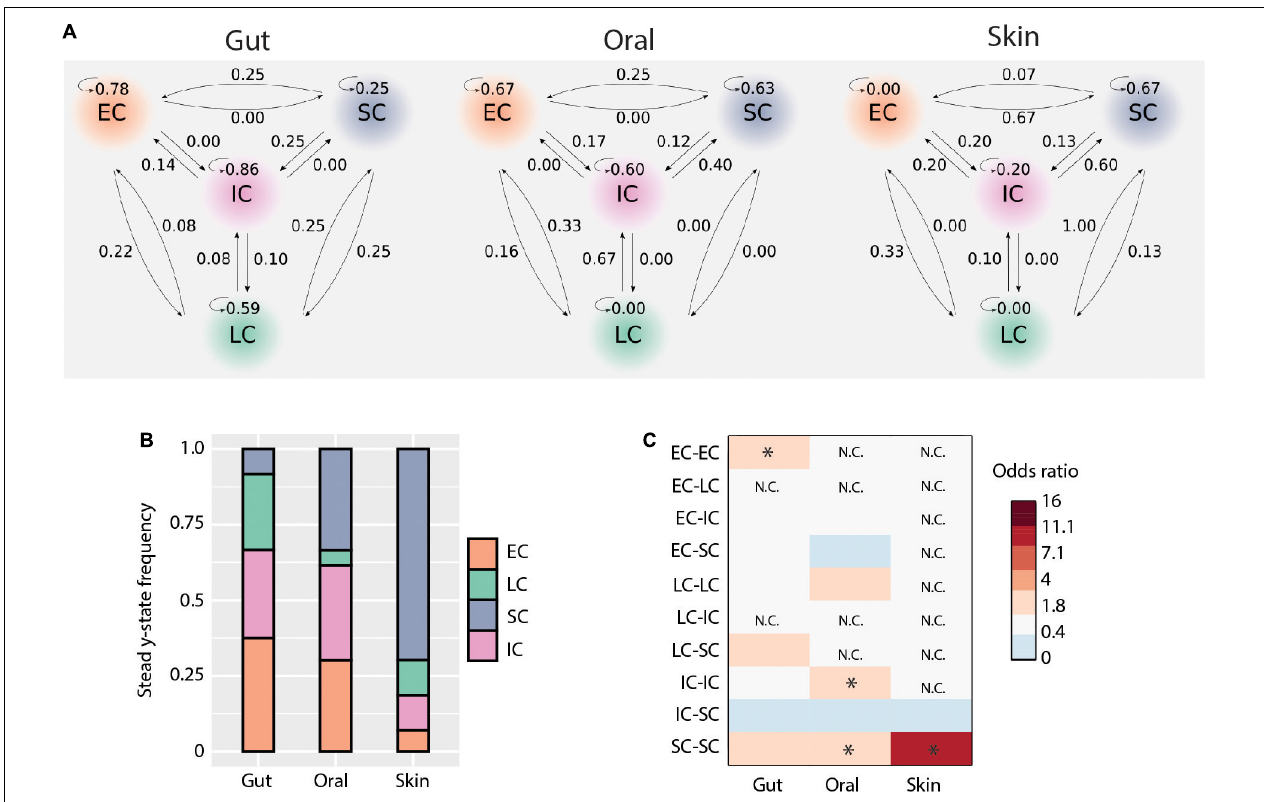
FIGURE 5 | Microbial transmission and community dynamics. (A) Schematic representation of transition probabilities across body sites. (B) Community types steady-state frequencies across body sites. (C) Contribution of each community type comparisons to deterministic processes (i.e., bNTI values > | 2|). The heatmap shows the odds ratio of each comparison to contribute to observed deterministic processes for each body site. Significant values (i.e., when the lower bound of the 95% confidence interval was above 1) are indicated by an